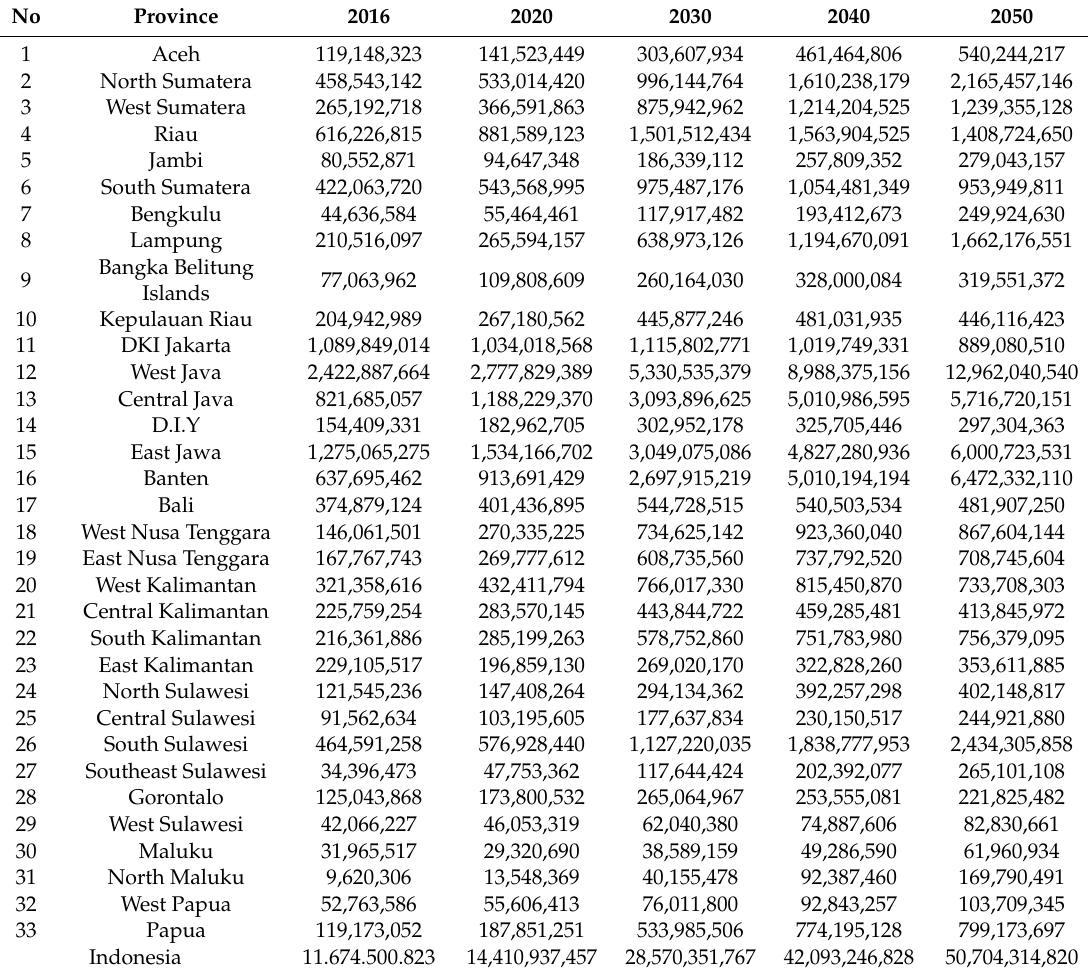
Table 10. Energy demand projections for provinces, BAU scenario, 2016–2050